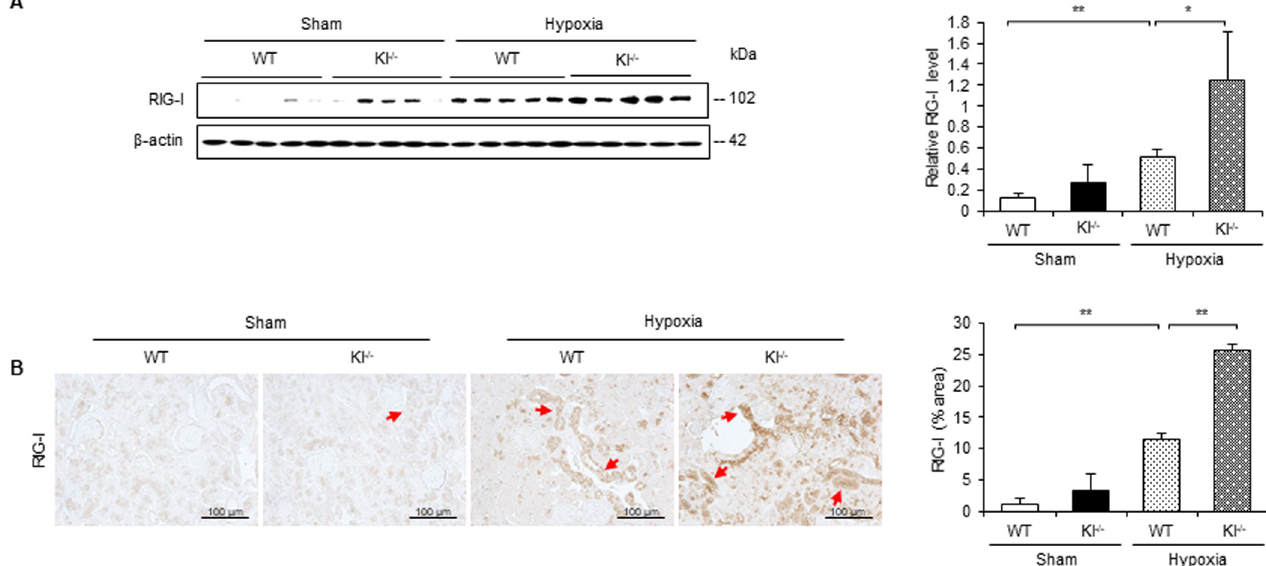
Fig 5. RIG-I expression is intensified under hypoxic conditions in Kl − / − mice. (A) Western blot analysis demonstrating RIG-I expression in WT and Kl − / − mice. Protein levels were normalized to β -actin levels (n = 5 in each group). (B) Representative immunohistochemical staining images showing expression and localization of RIG-I in WT and Kl − / − mice. Values are mean ± SD. � P < 0.05, �� P < 0.01. Bar = 100 μ m.